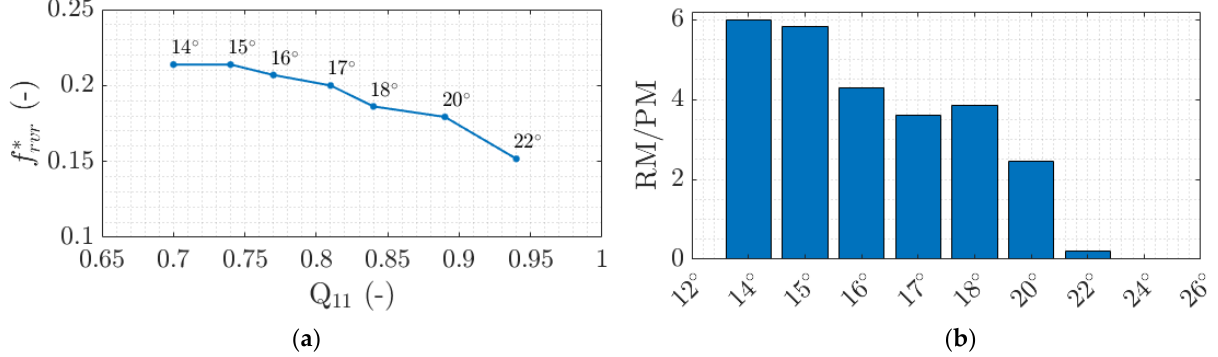
Figure 7. Frequency values of the RVR pressure peaks in position P1x 0° ( a ) and relative amplitudes of the RM pressure peaks over the PM peaks from the decomposed signals with Equations (4) and (5) for the signals in positions P1x 0° and P1x 180° ( b ) at different discharges.